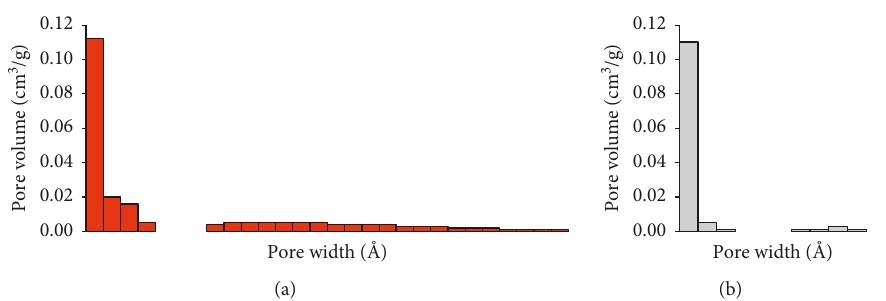
Figure 3: Pore volume distributions of active carbon samples according to the DFT (density functional theory) method. (a) Physically activated carbon (PAC). (b) Chemically activated carbon (CAC).